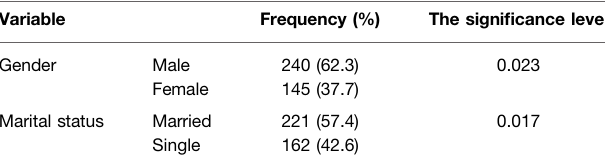
TABLE 4 | The relationship between clinical characteristics of low back pain and demographic characteristics of the operating room personnel.